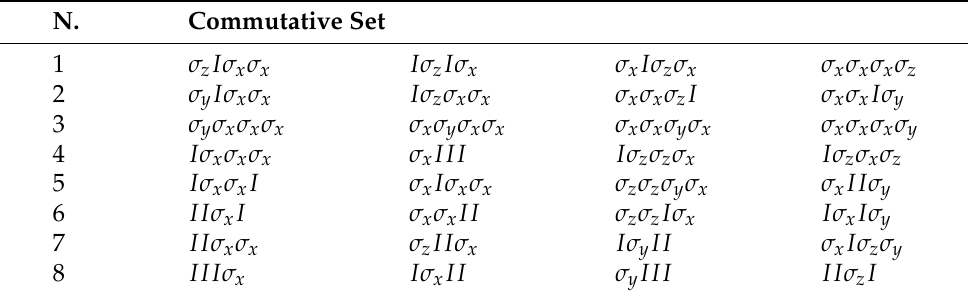
Table 4. Commutative sets (generators) whose eigenstates form a WUS of degree 8. N.